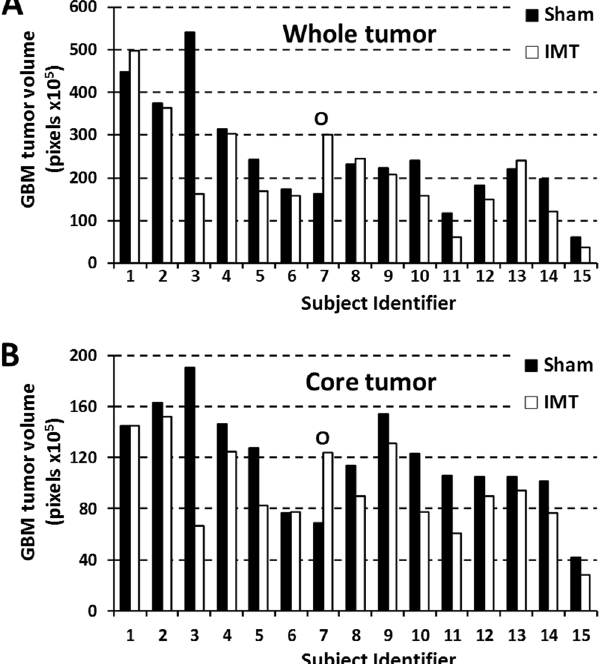
Figure 5. Paired in vivo GBM responses to sham and IMT conditions. Raw tumor measures calculated from the ( A ) whole tumor and ( B ) core tumor are shown after sham treatment (black) or IMT (white). The statistical outlier shown in Fig. 4 has been left in this dataset for completion (subject #7; labeled O). The IMT-treated GBM was smaller than the sham-treated tumor in 11 of 15 (73%) and 12 of 15 (80%) subjects using whole and core tumor measures, respectively.